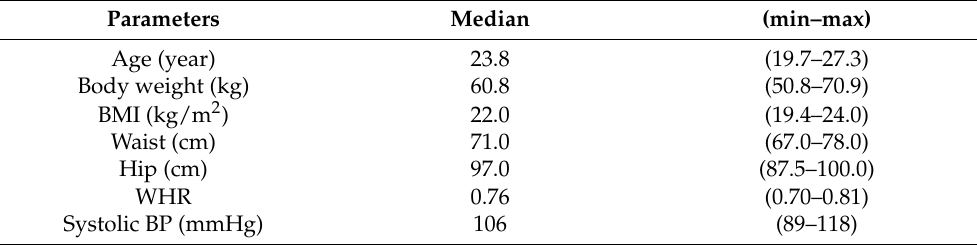
Table 1. Subject characteristics 1,2